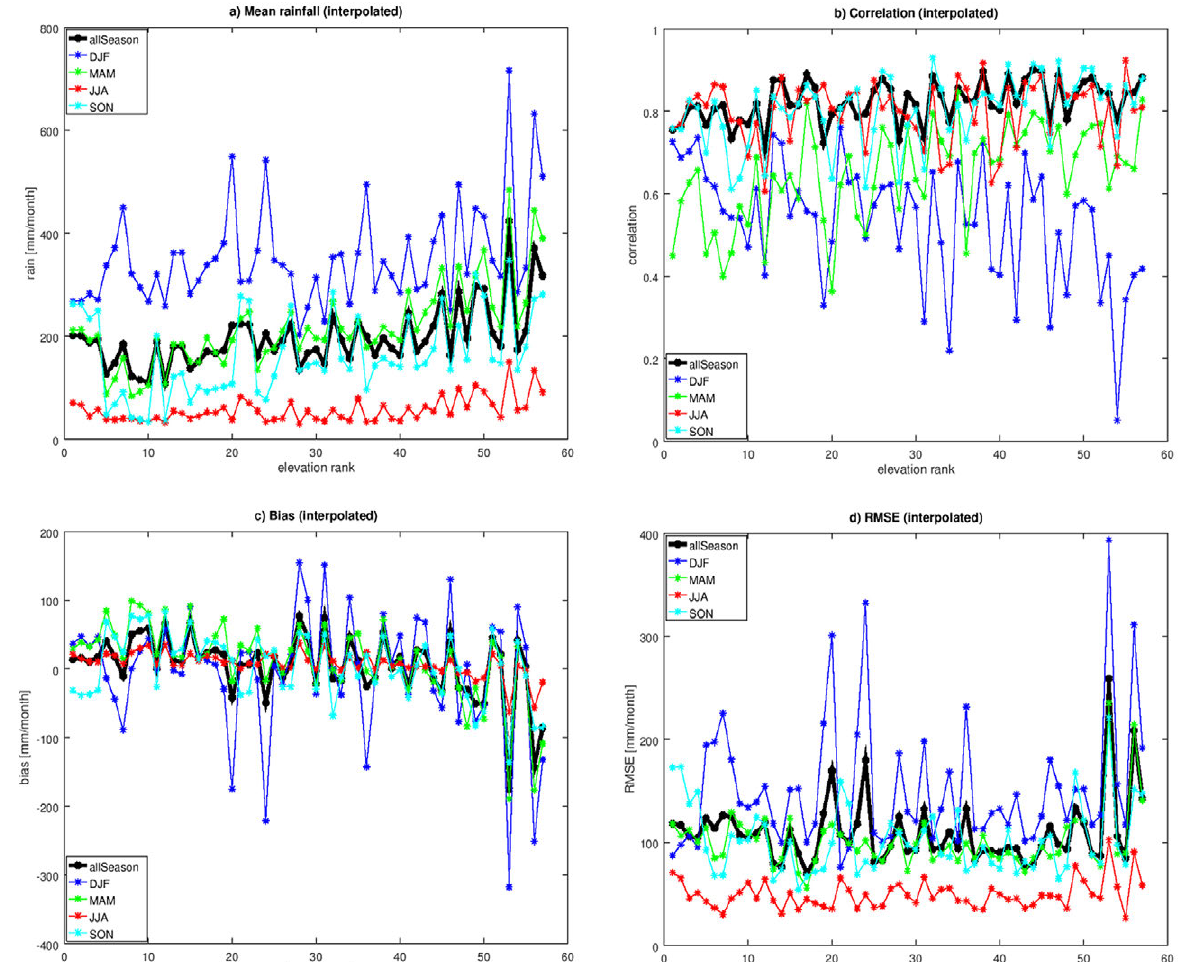
Fig. 12. Similar to previous figure, but for moving average interpolated rainfall data. The plot are based on grid elevation rank from the lowest to the